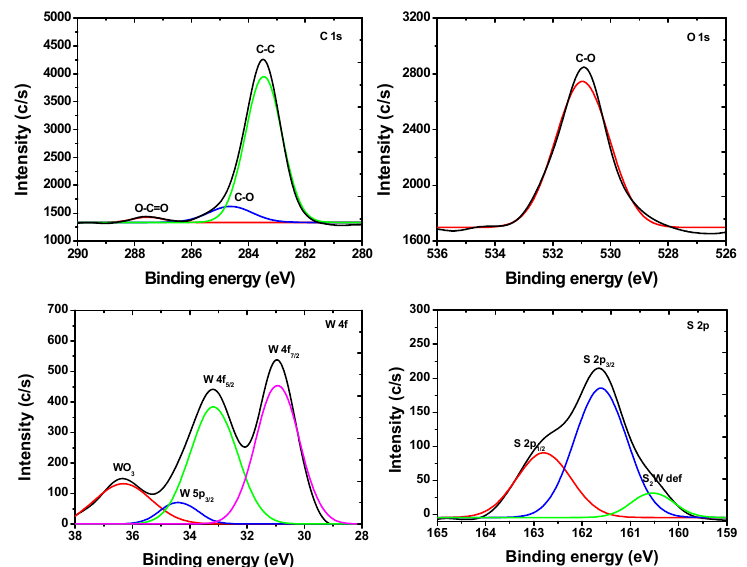
Figure 4. High-resolution core level spectra of WS 2 nanoflowers with focus on C1s, O1s, W4f and S2p. The blue, green, red and purple lines are their respective deconvoluted spectra. Table 1 . Summary of the atomic composition stoichiometric assignments obtained from the fitting of the XPS spectra of WS 2 nanoflowers.